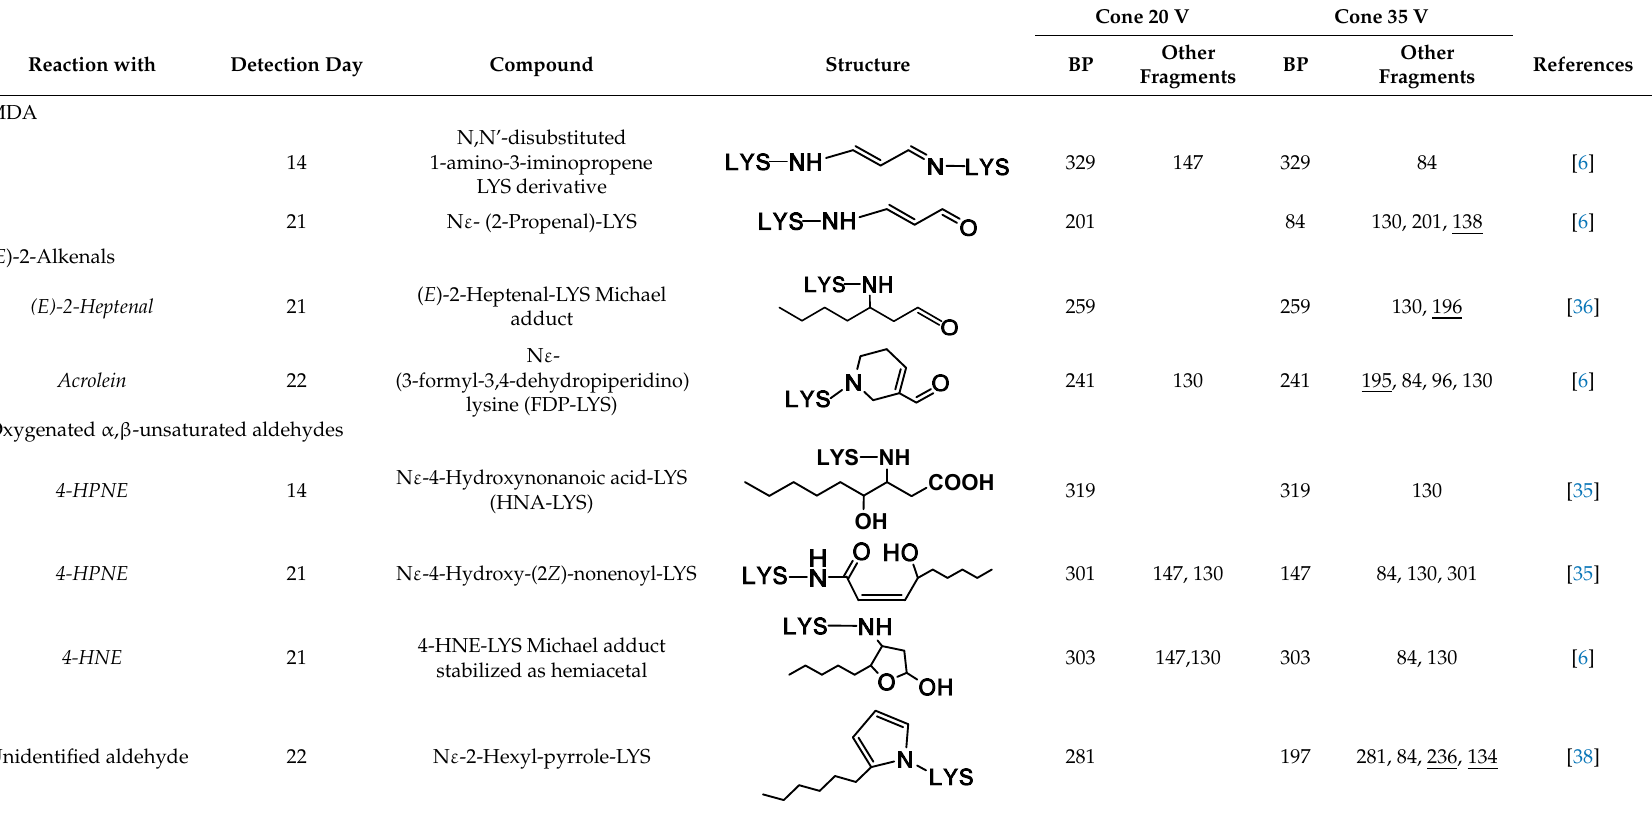
Table 2. Compounds coming from the reaction of lysine with aldehydes different from n-alkanals, tentatively identified by LC–MS in the aqueous extracts of the RSO + 2LYS sample obtained throughout the oxidation process, together with their detection day, structure, mass spectra base peaks (BP), and other fragments of their mass spectra. The underlined ions are characteristic of each adduct. MDA: malondialdehyde; LYS: lysine; 4-HPNE: 4-hydroperoxy-( E )-2-nonenal; 4-HNE: 4-hydroxy-( E )-2-nonenal.